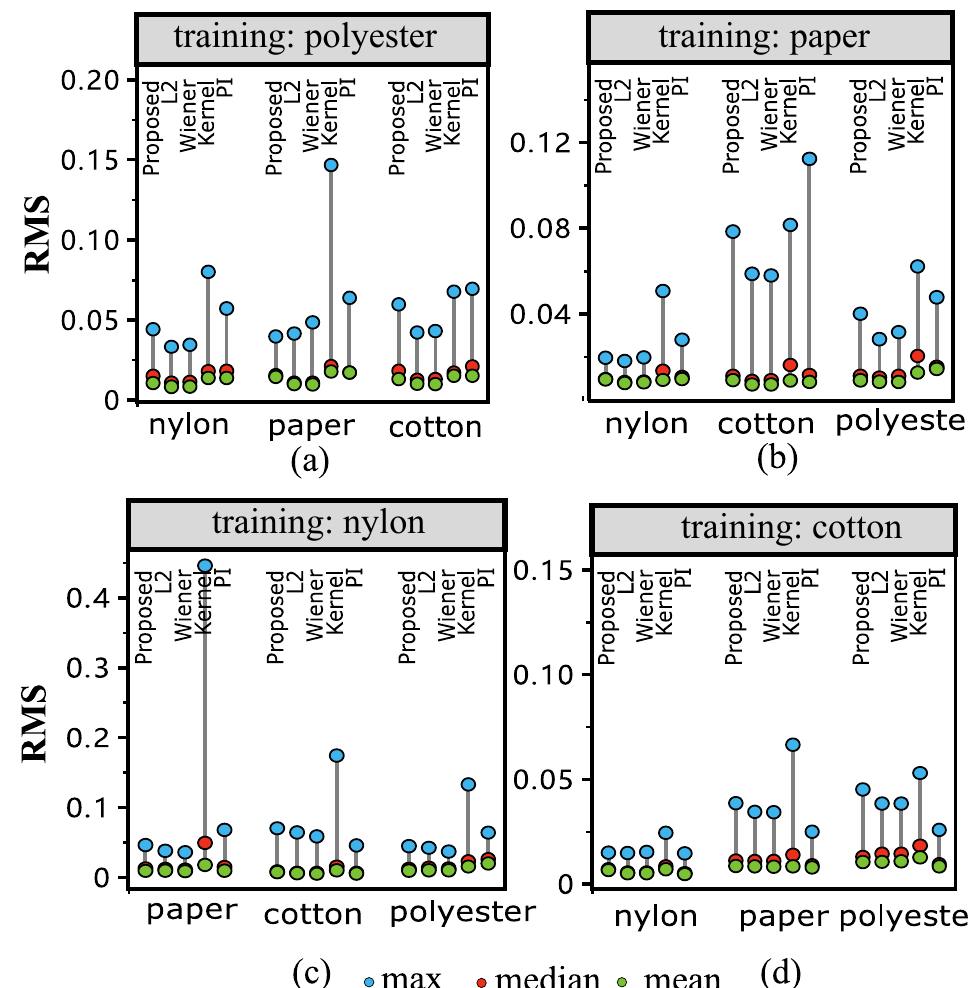
Figure 7. RMS results of spectral reflectance reconstruction using different materials as training. “Proposed” refers to our L1-norm penalization method, “L2” refers to the ridge regression (L2-norm penalization), “Wiener” refers to the Wiener method, and “PI” refers to the least-square estimation (pseudo-inverse method). Sub-figures ( a – d ) show the results of using polyester, paper, nylon, and cotton as training samples, respectively. Results show that the proposed method is comparable with other methods in the reflectance space; more detailed description is provided in the